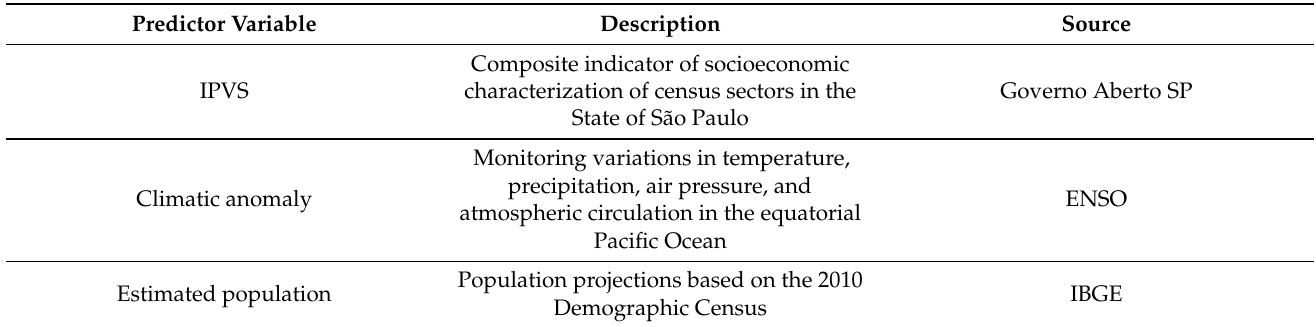
Table 1. Description of the predictor variables.